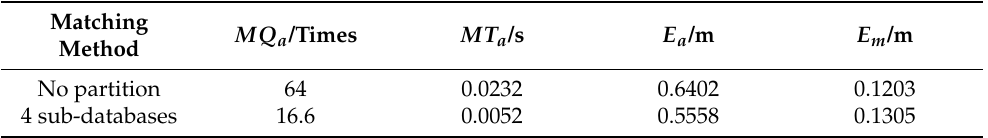
Table 2. Comparison of the localization results between the traditional RPs matching method and the novel method based on clustering